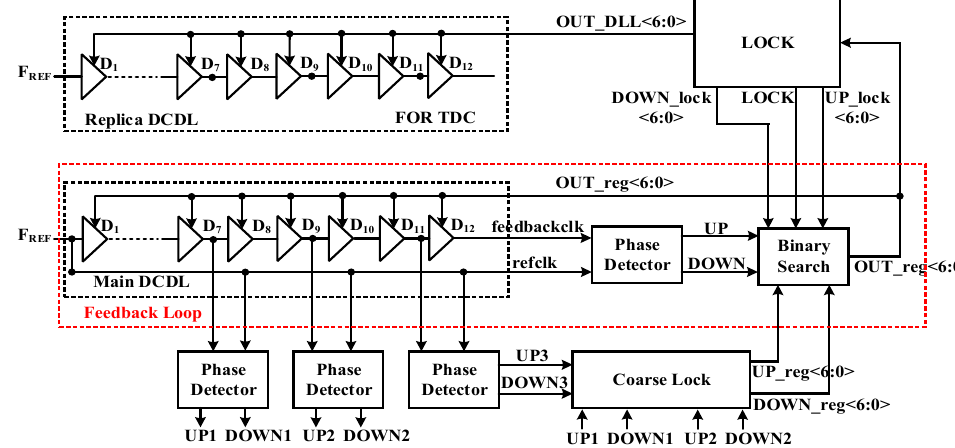
Figure 2. The architecture of the proposed ADDLL.